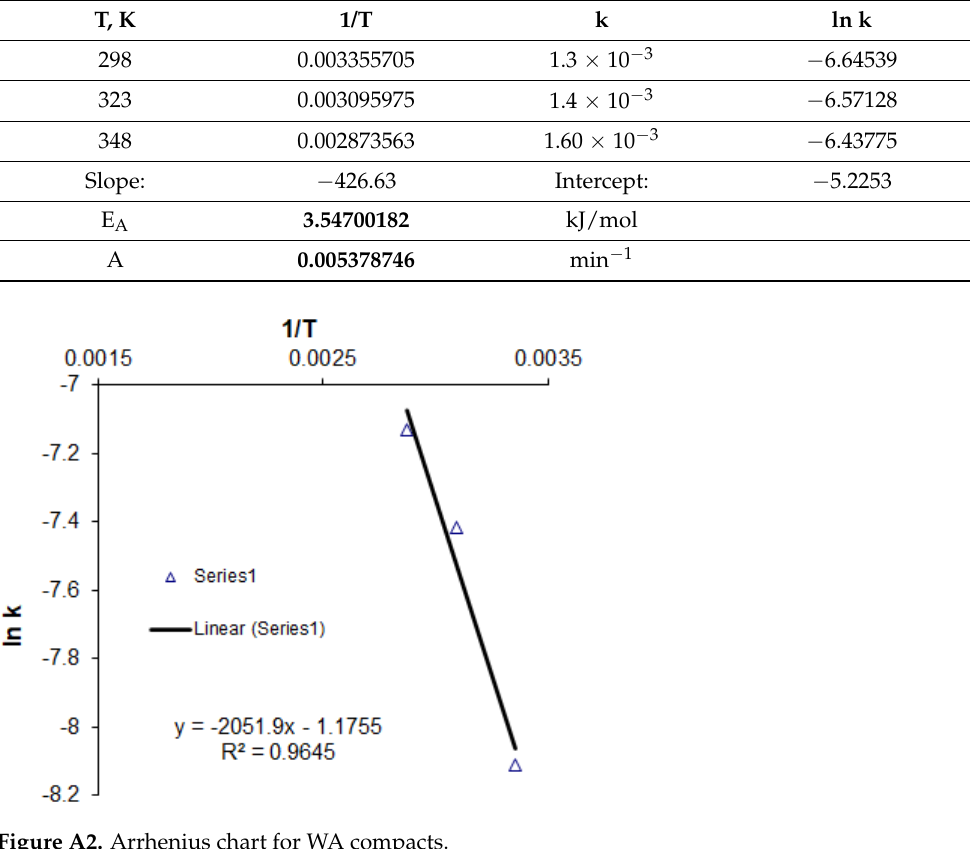
Figure A1. Arrhenius chart for OSA compacts. Table A2. Reaction parameters for OSA compacts. Table A2. Reaction parameters for OSA compacts.